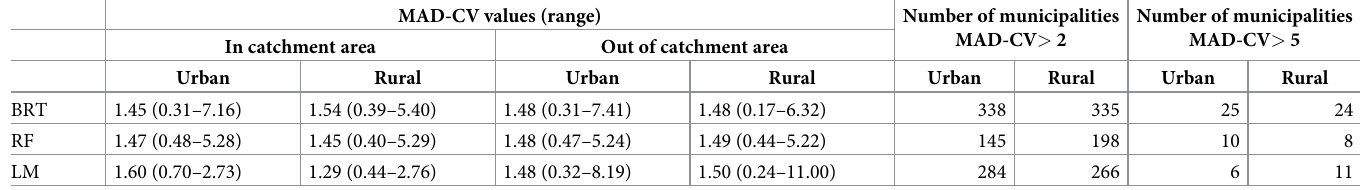
Table 3. Uncertainty across Chagas disease Force-of-Infection predictions for the three frameworks under comparison. The uncertainty was estimated using the Median Absolute Deviation Coefficient of Variation (MAD-CV) of the predictions for Colombia in 1990, in (urban and rural) areas where at least one serosurvey had been conducted (‘in catchment area’) and where no data were available or used in the analyses (‘out of catchment area’). The number of municipalities where MAD-CV is greater than 2 (substantial uncertainty) or greater than 5 (extreme uncertainty) is also included.